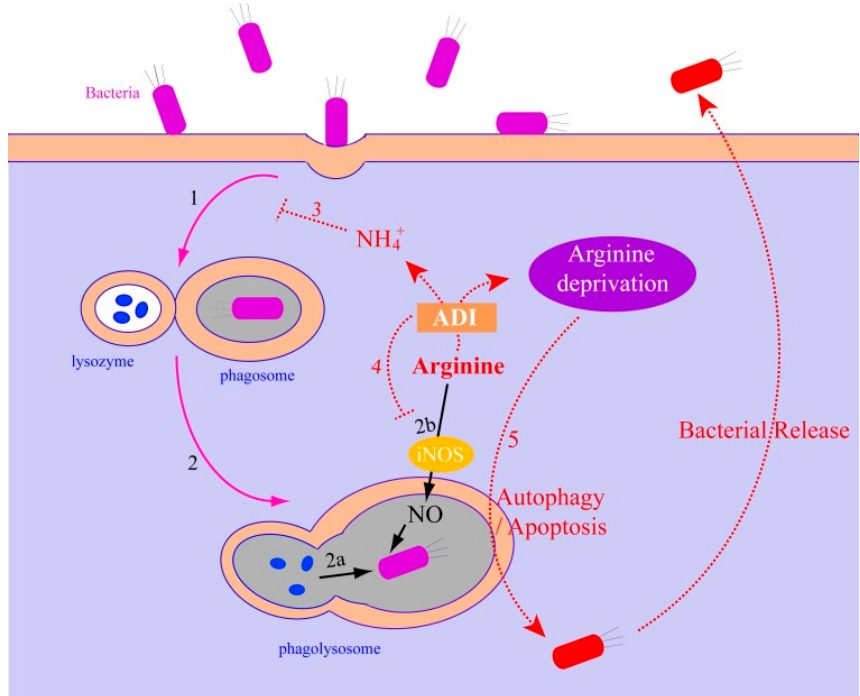
Figure 2. Proposed model for intracellular killing of bacteria by phagocyte and bacterial defense strategies against phagocytosis. Bacteria could be engulfed by a phagocyte into the phagosome ( 1 ), followed by fusion with a lysozyme to form a phagolysosome ( 2 ), being killed by varied strategies like pH decrease, enzymes (solid blue oval) release ( 2a ), and production of antimicrobial NO by iNOS ( 2b ). We propose that the bacteria containing ADI pathway genes may employ this pathway to defend these killing strategies in the following ways: firstly, the production of ammonia could probably raise the cytoplasmic pH, thereby inhibiting the formation of phagolysosome ( 3 ); secondly, the ADI pathway competes with iNOS for the common substrate (arginine), thereby reducing NO production ( 4 ); thirdly, arginine depletion would also activate the autophagy and/or apoptosis pathways, like that in cancer cells (Figure 3), to induce programmed cell death and release bacteria ( 5